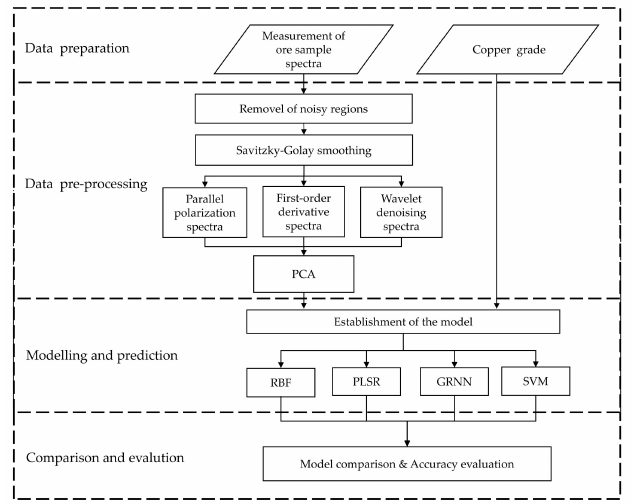
Figure 6. The flow chart of copper grade